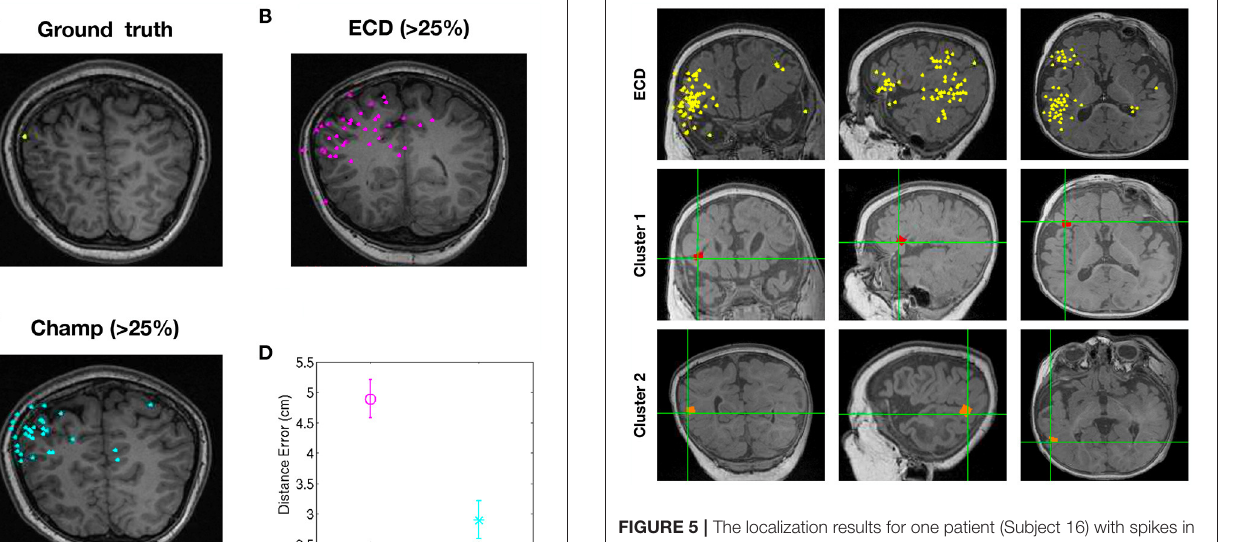
“SESAME” was evaluated by Luria et al. (2020) and was concordant with standard ECD fitting done by experienced